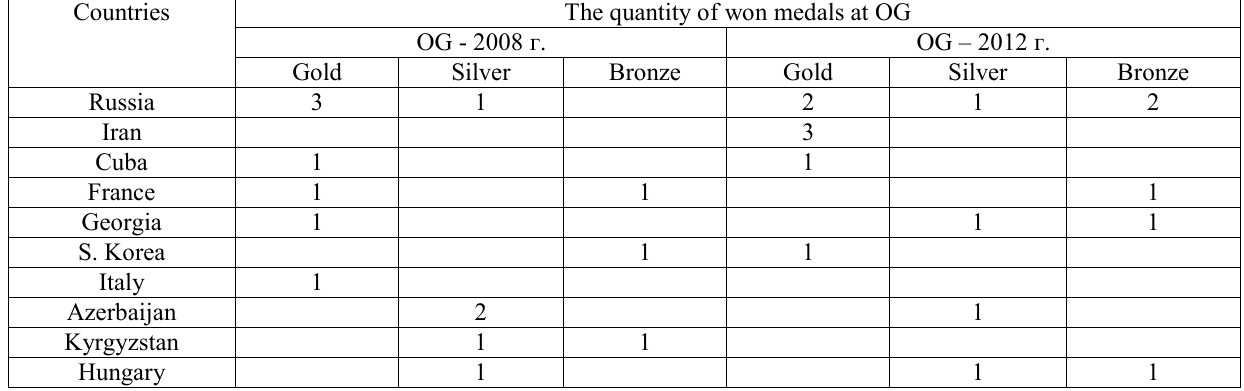
Countries that won medals at Olympic Games (OG)-2008 and OG-2012 Countries The quantity of won medals at OG OG - 2008 г. OG – 2012 г. Silver Bronze Gold Silver